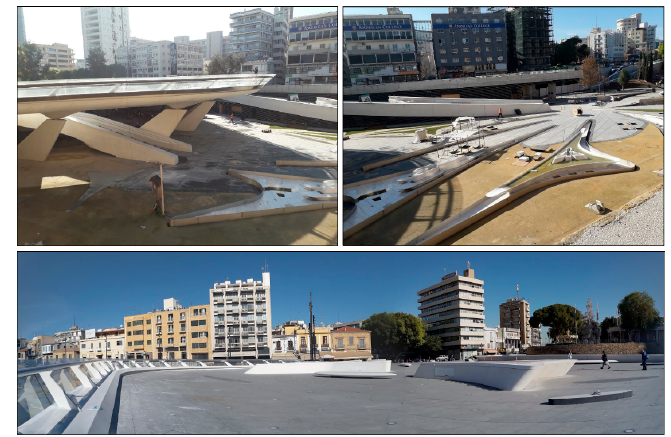
Figure 4. Eleftheria Square project: photographs of the work in progress captured in December 2019.